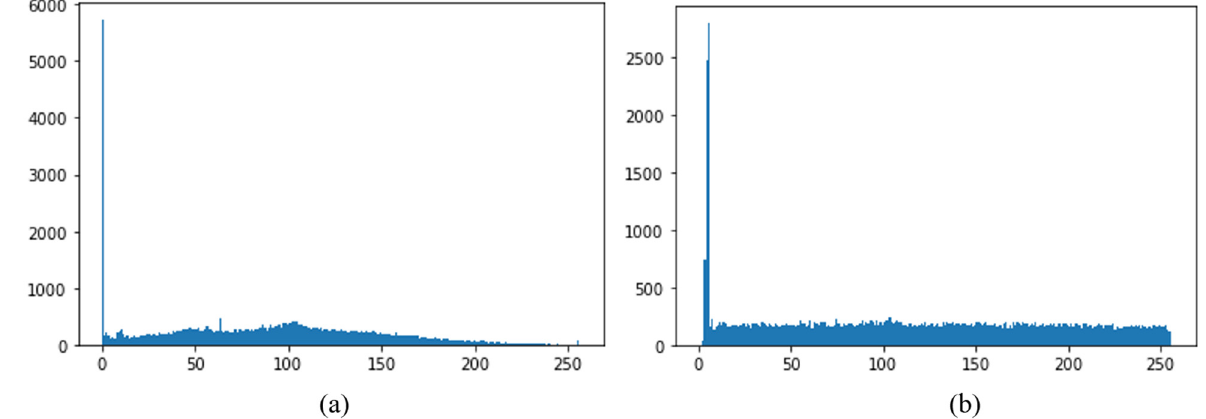
Figure 7. Image before ( a ) and after ( b ) imposing histogram equalization.